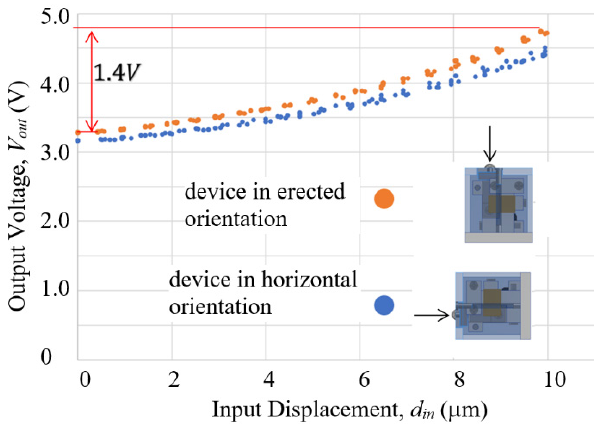
Figure 33. A second setup for testing/calibrating the LCMDS prototypes at different orientations, the picture showing the setup operating in horizontal orientation.